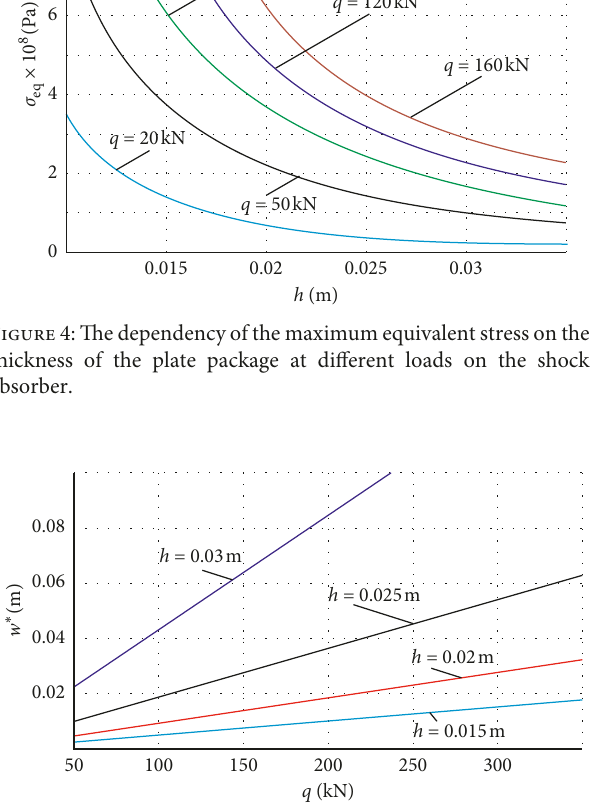
Figure 5: Diagram of the submersion of the elastic suspension from the external load at different thicknesses of the plate